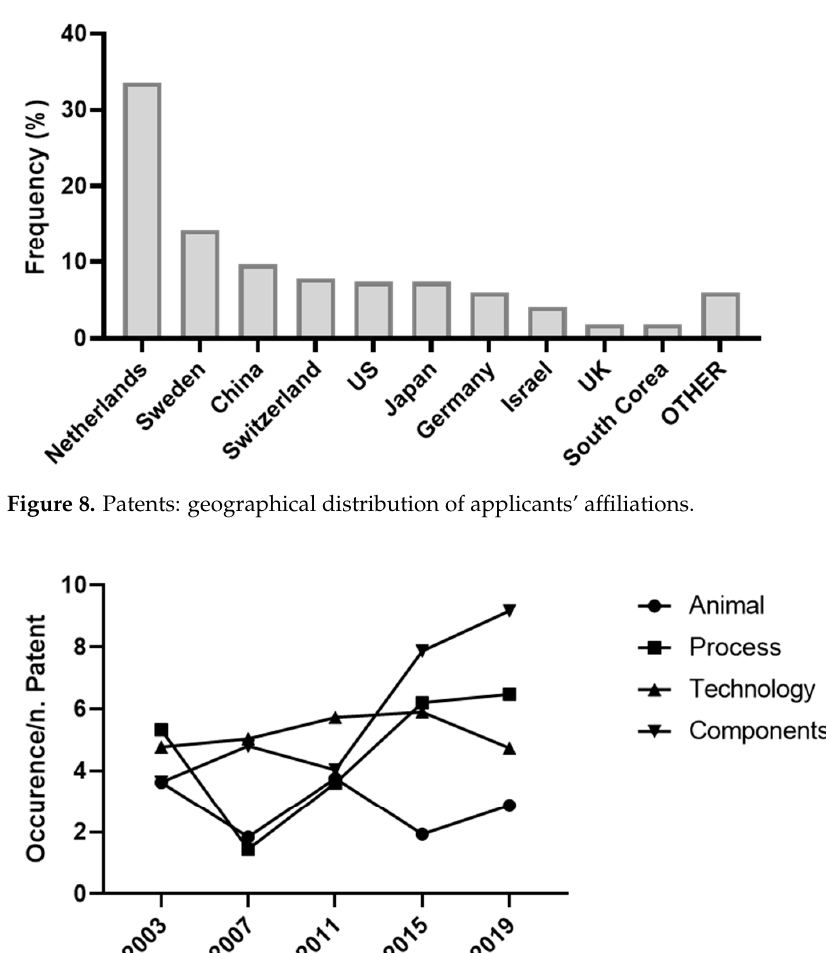
Figure 7. Patents: course of patents released over the observed period.